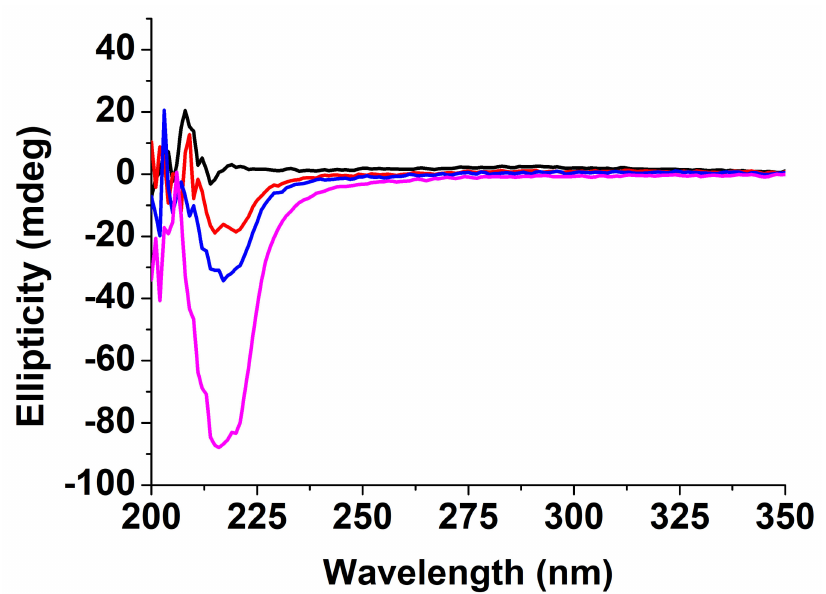
Figure 6. CD spectra of the gel Boc- α ( S )Phe- α ( S )Phe-OH (black = directly after the addition of HCl into the cuvette at t0, red = after 1 h, blue = 2 h, and magenta = 20